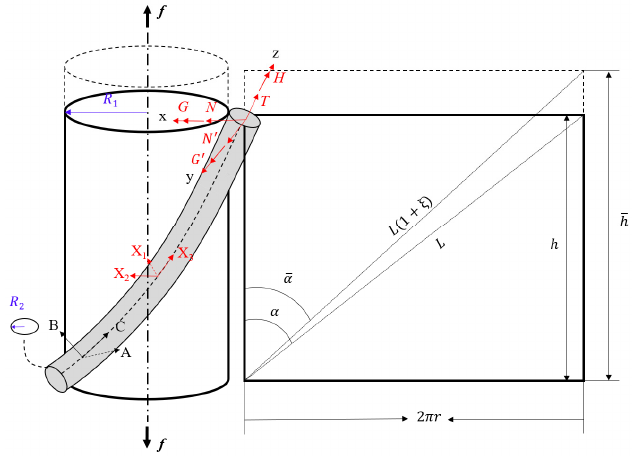
Figure 3. Schematic diagram of the deformation of the helically wound structure.